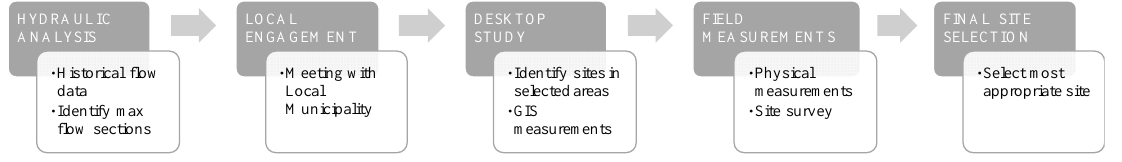
Figure 1. Site selection procedure.